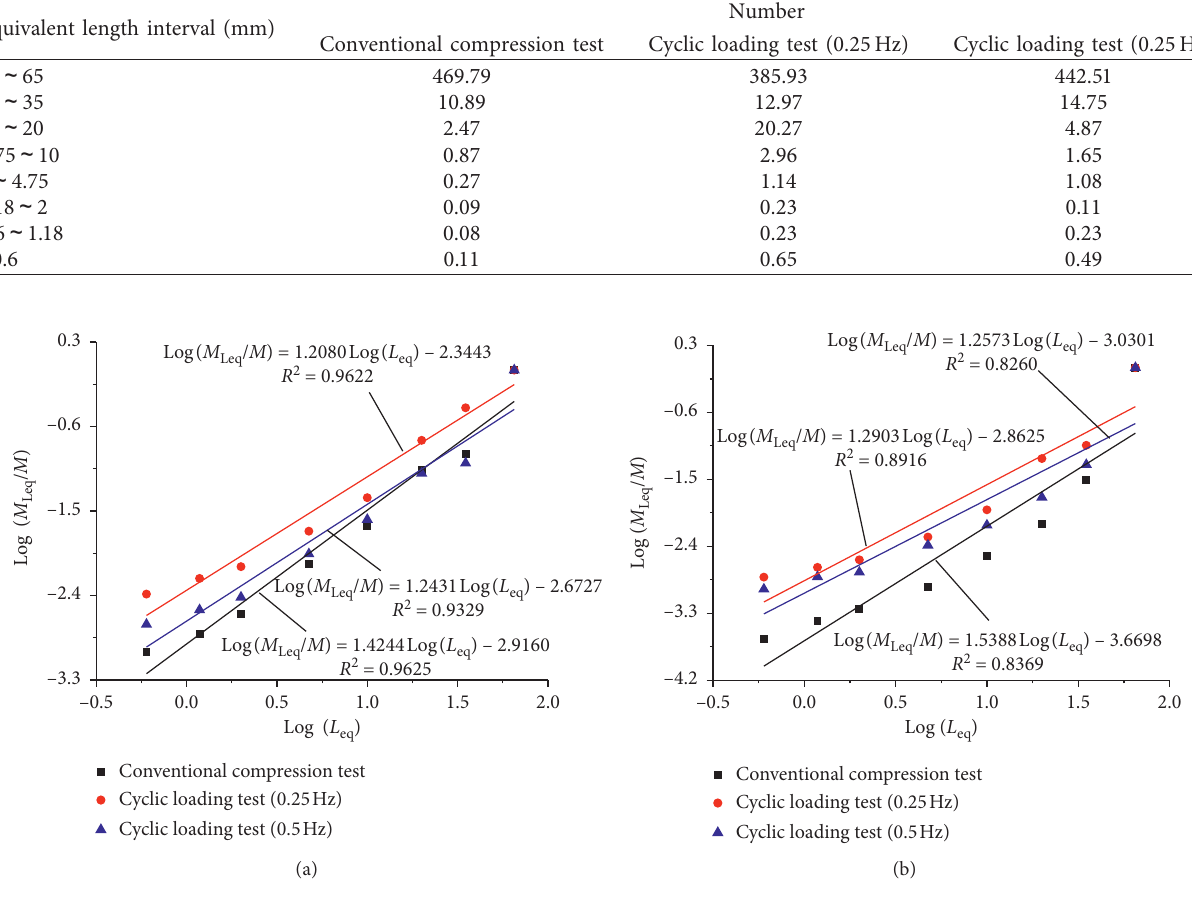
Figure 18: Logarithmic plot of the limestone fragment equivalent length-weight. (a) Uniaxial stress state. (b) Confining pressure of